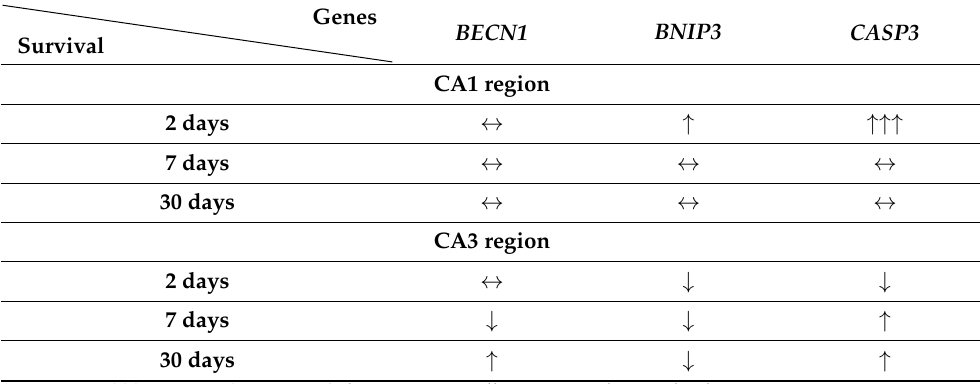
Table 2. Changes in the expression of autophagy (BECN1), mitophagy (BNIP3) , and apoptosis (CASP3) genes in the CA1 and CA3 areas of the hippocampus at different times after brain ischemia. Genes BECN1 BNIP3 CASP3 Survival CA1 region 2 days ↔ ↑ ↑↑↑ 7 days ↔ ↔ ↔ 30 days ↔ ↔ ↔ CA3 region 2 days ↔ ↓ ↓ 7 days ↓ ↓ 30